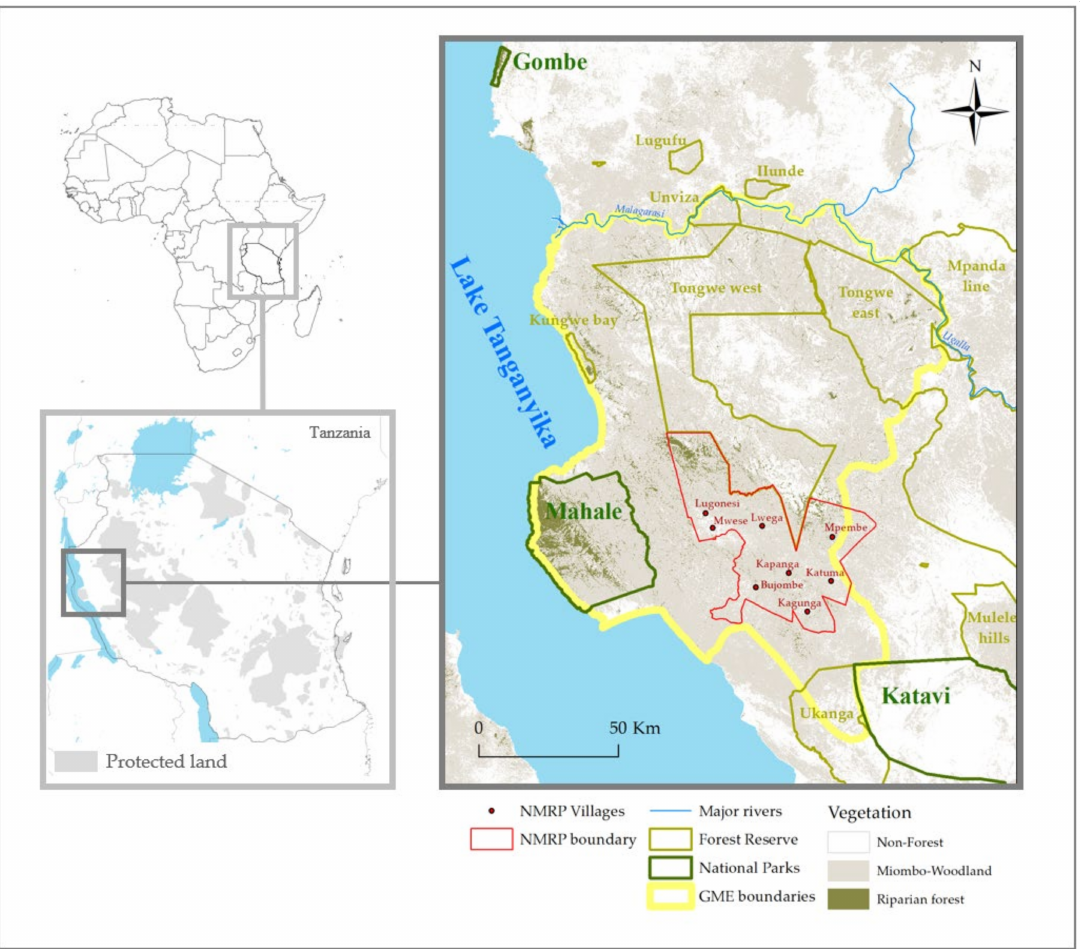
Figure 1. Location of Ntakata (REDD) project in Tanzania. All maps are in projection WGS84 UTM Zone